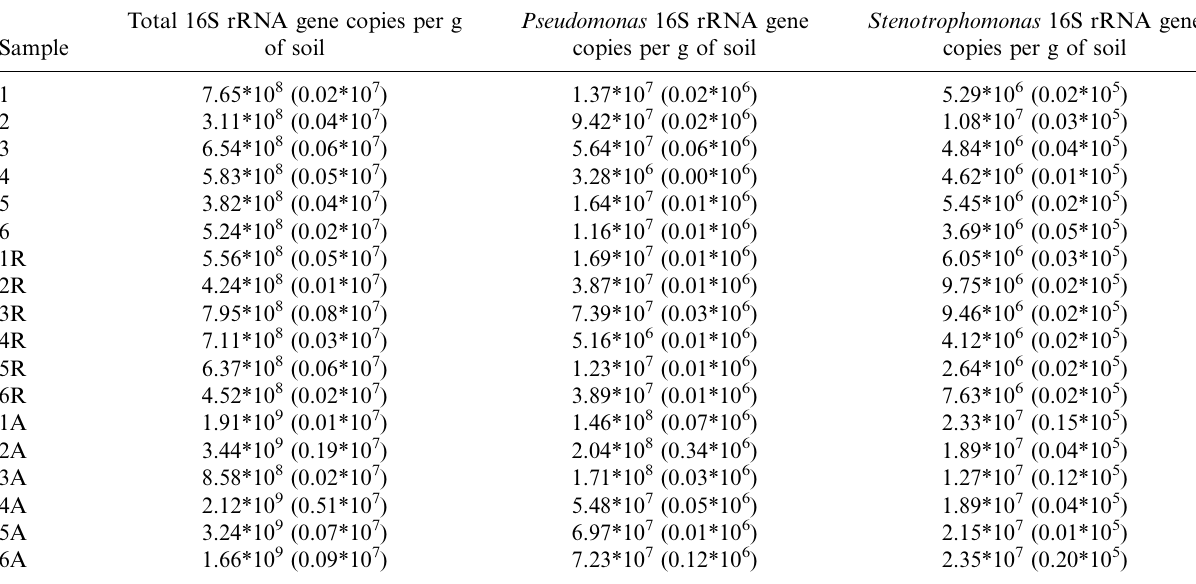
Table 4. Quantification of 16S rRNA genes of total and selected functional groups of microbial community in soil samples. Sample labels are given in Table 1. Standard deviation is shown in brackets